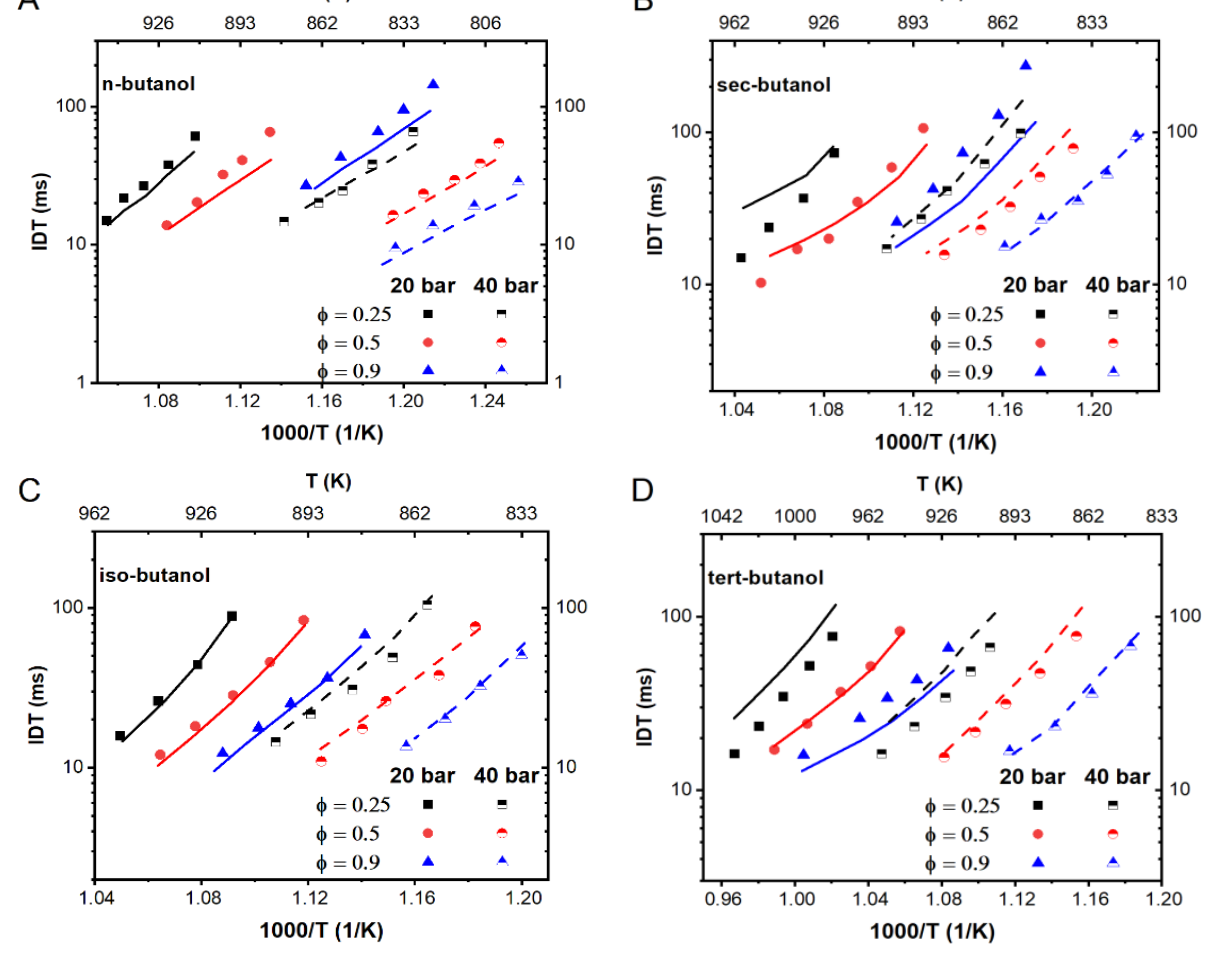
Figure 11. IDTs of ( A ) n-butanol, ( B ) sec-butanol, ( C ) iso-butanol, and ( D ) tert-butanol measured in the RCM [39–41] at 20 and 40 bar and φ = 0.25, 0.5 and 0.9. (Symbols: experimental points; Lines: model predictions).